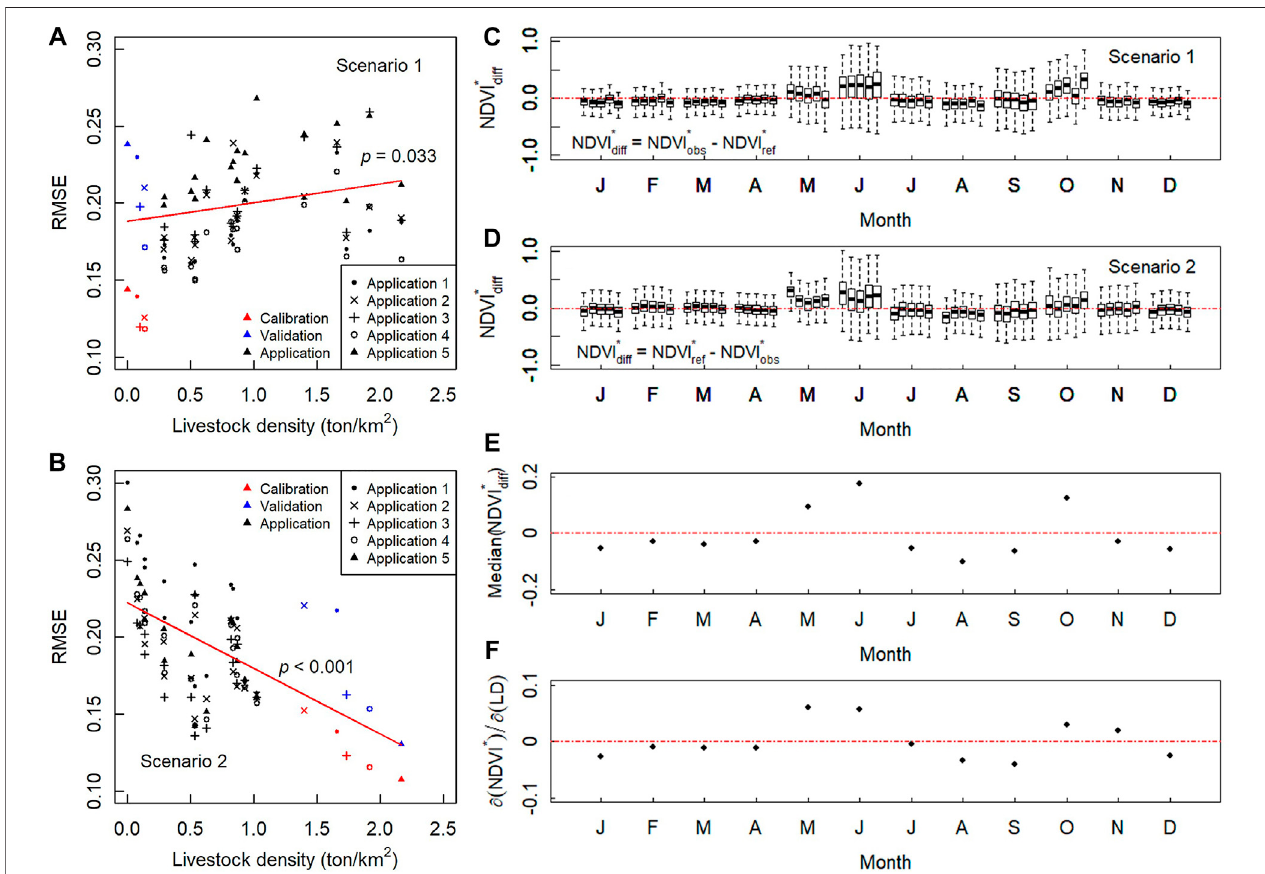
FIGURE 2 | Attribution of grazing effects. (A) RMSE for S1; (B) RMSE for S2; (C) NDVI * diff for S1; (D) NDVI * diff for S2; (E) Median NDVI * diff ; (F) Slope for the linear relationship between NDVI * diff and ( LD − LD 0 ) (Related scatter points are presented in Supplementary Figure S7